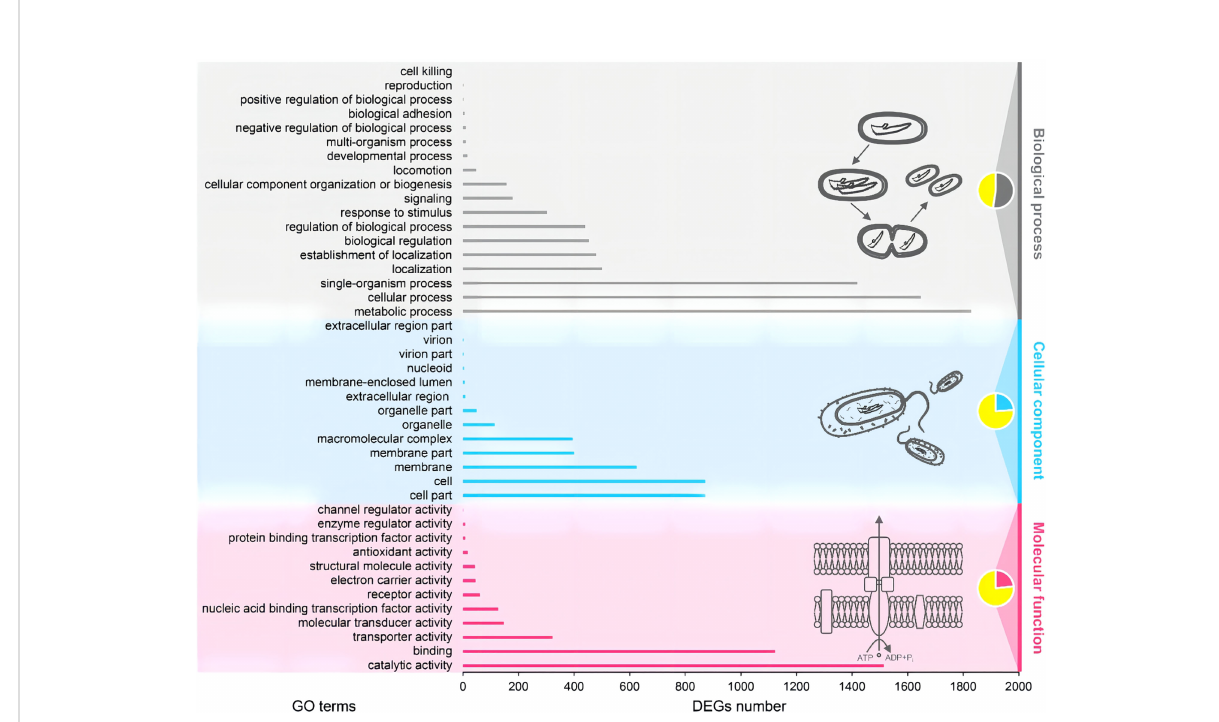
FIGURE 3 Gene ontology (GO) functional classi fi cation of A. hydrophila MX16A. DEGs, Differentially expressed